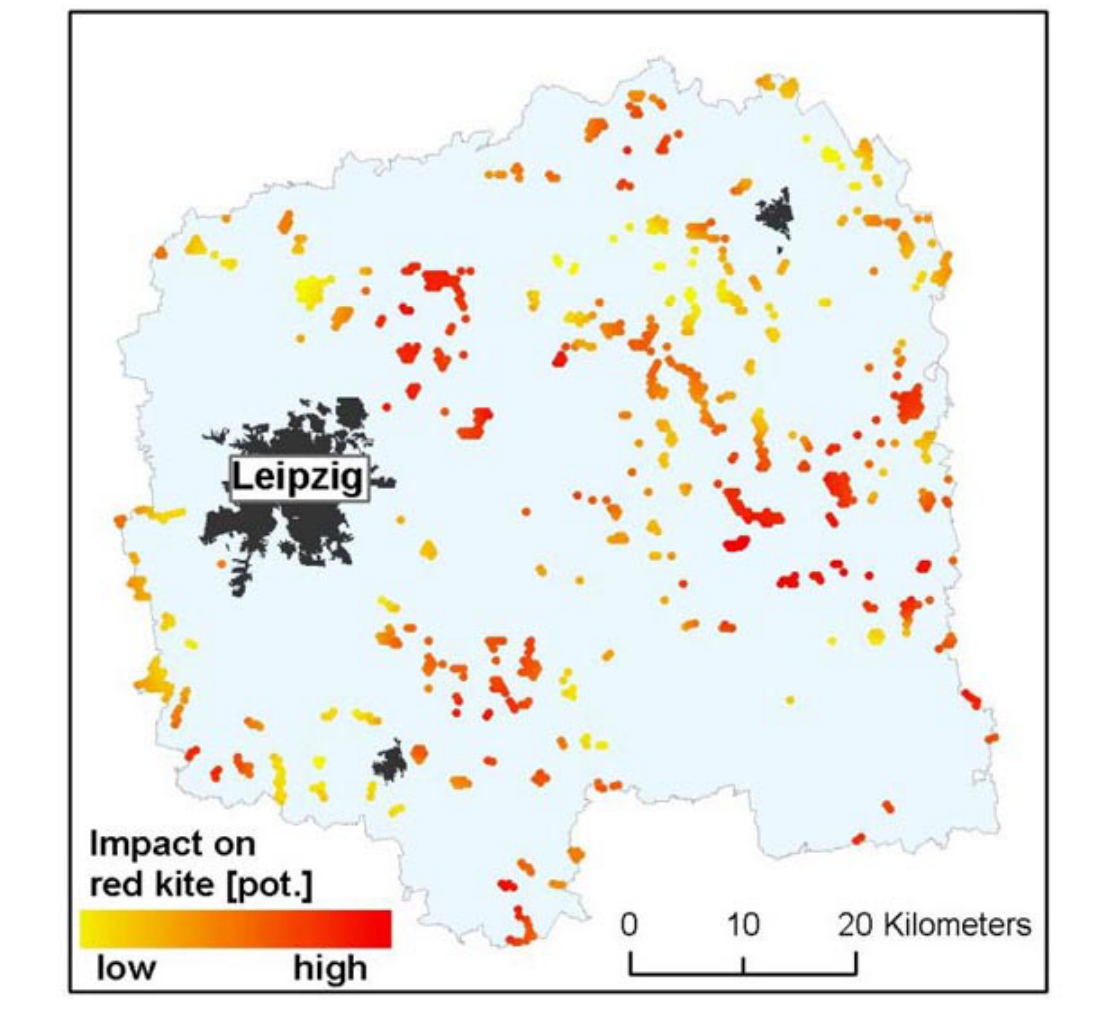
Fig. 4 . Impact map. Each dot represents a potential wind turbine site. Colors represent the ecological impact of a wind turbine at the site. Black represents